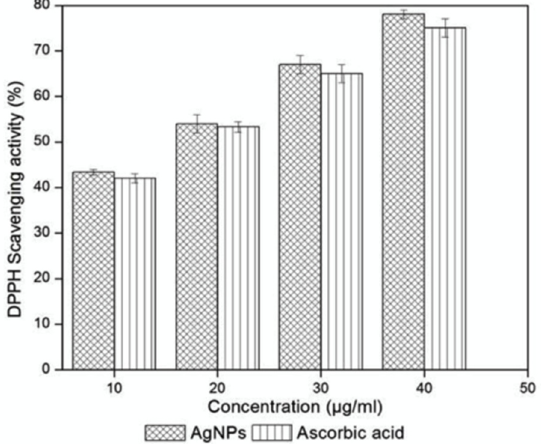
Figure 7. DPPH free radical scavenging assay for AC-AgNPs was related to the standard. Measure- ments were completed in triplicate (n = 3, mean ± SD) in a bar chart.